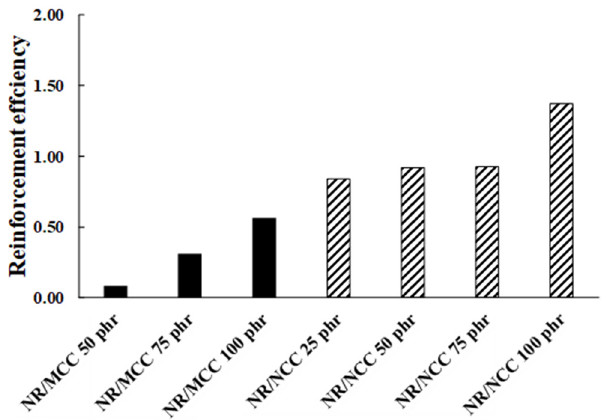
Figure 11. Filler reinforcing efficiency in different NR composites.